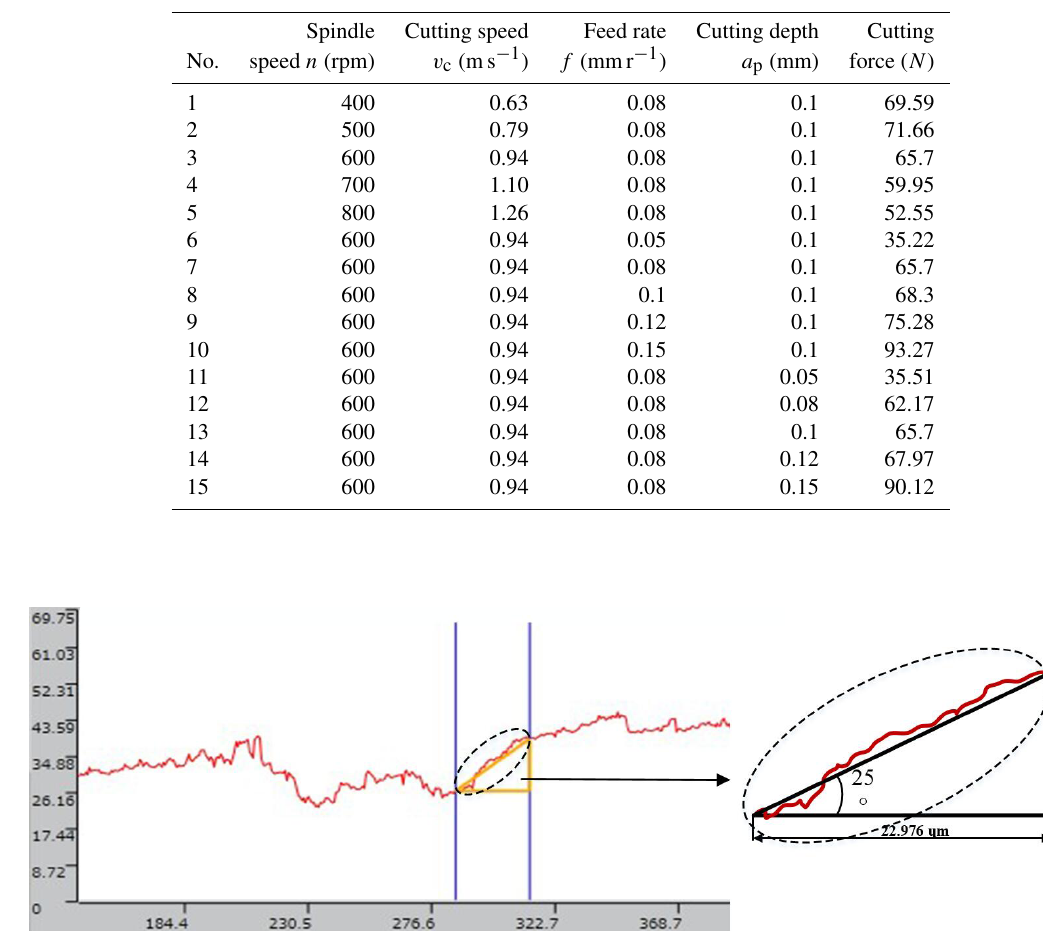
Table 1. Single-factor experimental conditions for fluorinated mica ceramics.